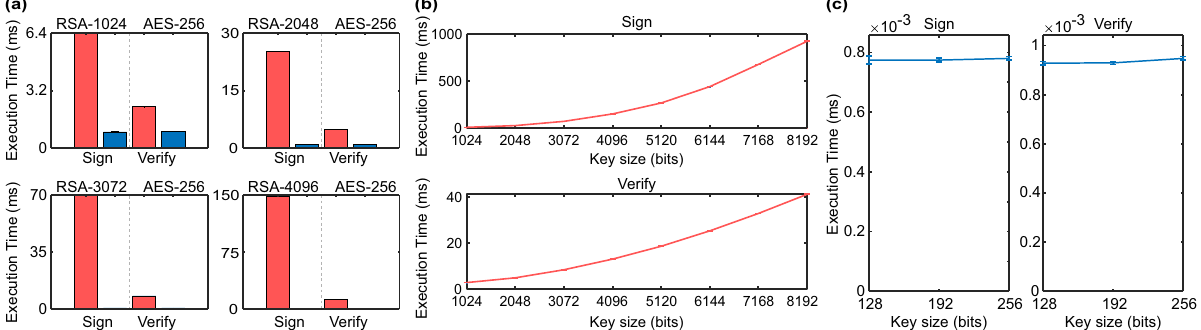
Figure 3. Measurement results for GMAC (blue) and Digital Signature (red) for ( a ) Execution times to authenticate a 256-byte message using GMAC and digital signature based on RSA with 1024, 2048, 3072, and 4096-bit and AES-256 bit keys. The vertical dotted lines are for visualization only to separate signing from verifying bars. ( b ) An extended measurement to show the trend of execution time for larger key sizes for RSA- based digital signature. ( c ) Authentication computation time of a 256-byte message using AES-based GMAC with s key sizes of 128, 192, and